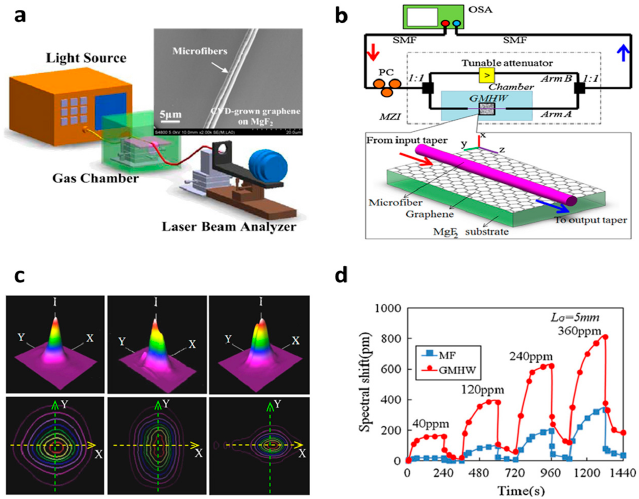
Figure 8. Optical gas sensors based on graphene attached on microfibers by using ( a ) mode-field analysis and power metering; ( b ) MZI interferometer; ( c ) Sensing performance of the graphene-based acetone gas sensor; ( d ) Sensing performance of the graphene-based MZI sensor for NH 3 gas detection. Here the results are reproduced from Ref. [52,84].